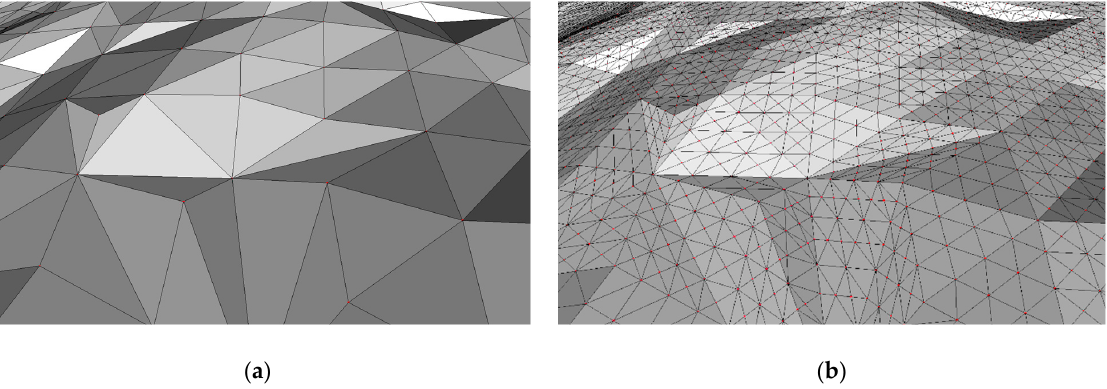
Figure 11. Example of using Midpoint algorithm for mesh subdivision: ( a ) original mesh; ( b ) subdi- vided mesh.